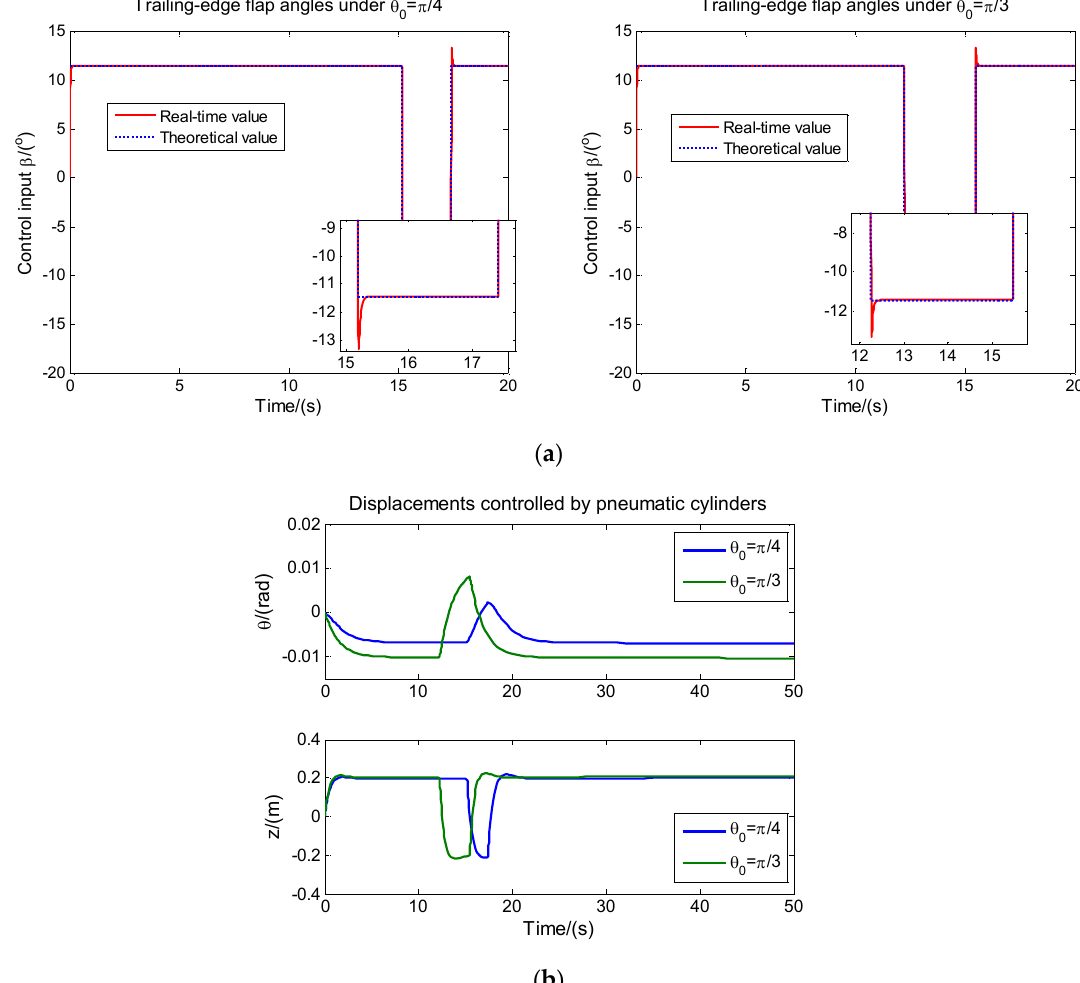
Figure 5. The real ‐ time tracking of trailing ‐ edge flap angles and the real ‐ time diaplacements Figure 5. The real-time tracking of trailing-edge flap angles and the real-time diaplacements controlled controlled by pneumatic cylinders under conditions of 𝜃 (cid:2868) (cid:3404) π/4,π/3 , respectively: ( a ) The real ‐ time by pneumatic cylinders under conditions of θ 0 = π /4, π /3, respectively: ( a ) The real-time tracking of tracking of trailing ‐ edge flap angles; ( b ) The real ‐ time diaplacements controlled by pneumatic trailing-edge flap angles; ( b ) The real-time diaplacements controlled by pneumatic cylinders.